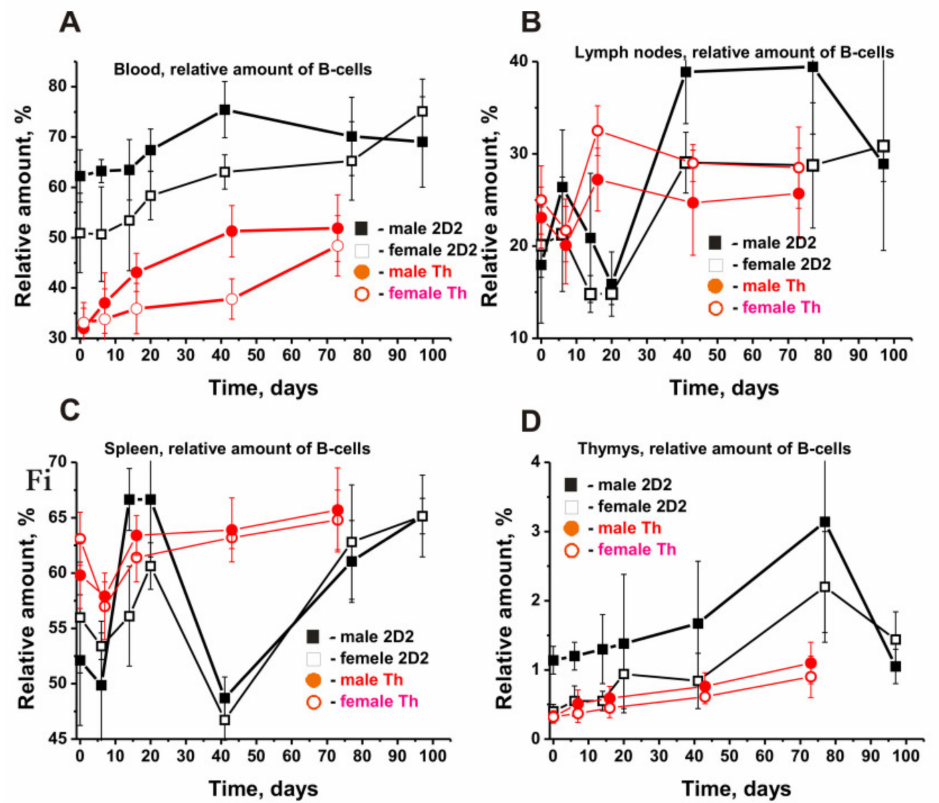
Figure 3. Time-related dependencies in the changes of relative numbers of B cells in different organs of 2D2 (black symbols) and Th (red symbols) males and females. All dependencies for all organs of various males and females are marked in the figures ( A – D ). For comparison, the data for Th mice were taken from our previously published articles [38,39]. The duration of the experiment and the time of blood sampling for different strains of mice were